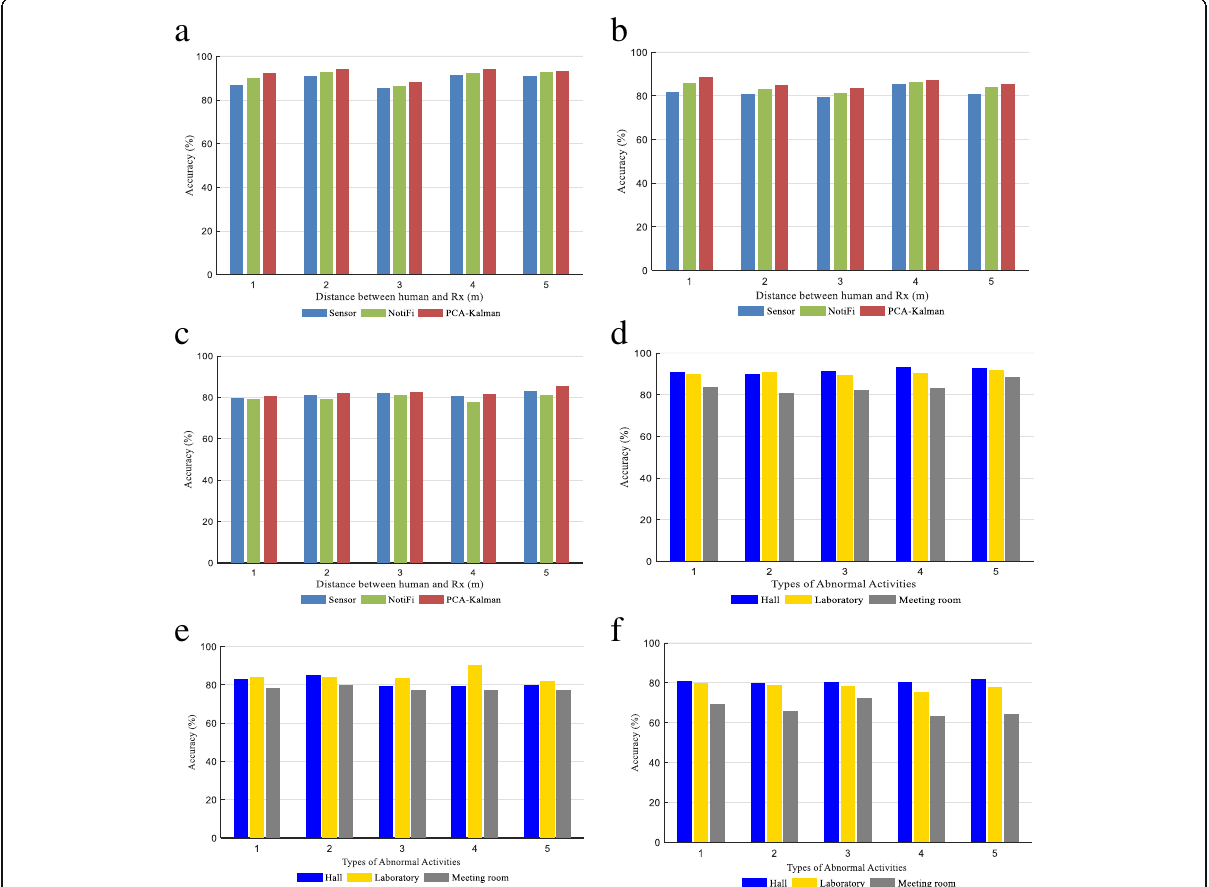
Fig. 10 a – c The accuracy of abnormal activity detection in different scenarios. d – f The robustness evaluation of PCA-Kalman respectively. a LOS. b NLOS. c Through one wall. d LOS. e NLOS. f Through one wall